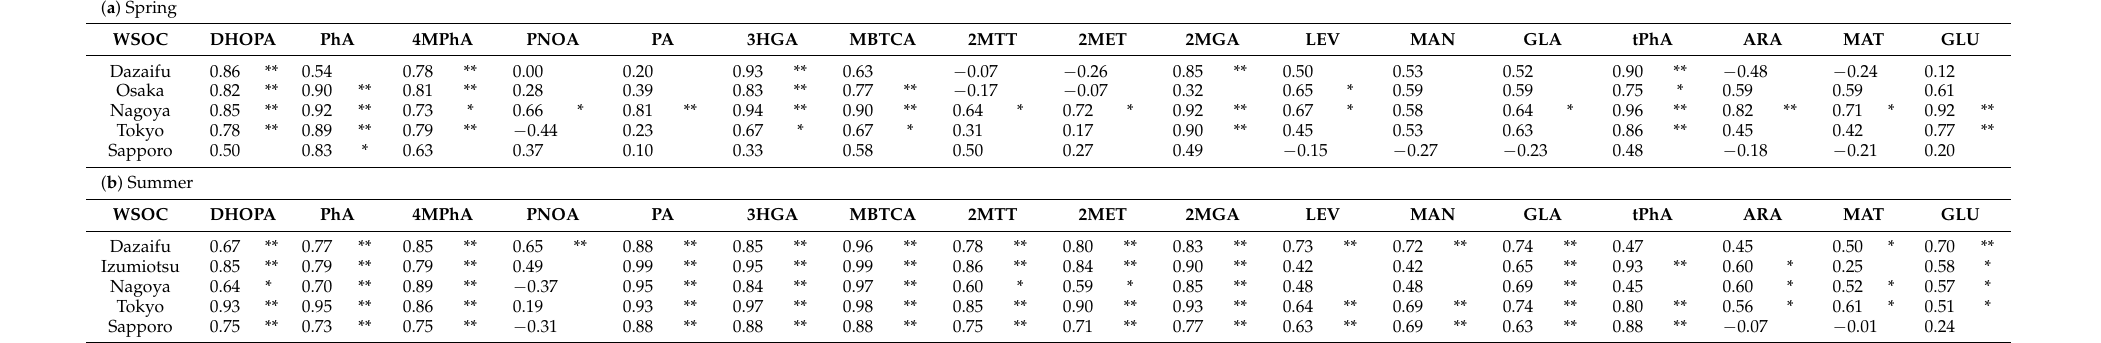
Table 5. Correlations between WSOC and organic tracers during ( a ) spring and ( b ) summer in each sampling